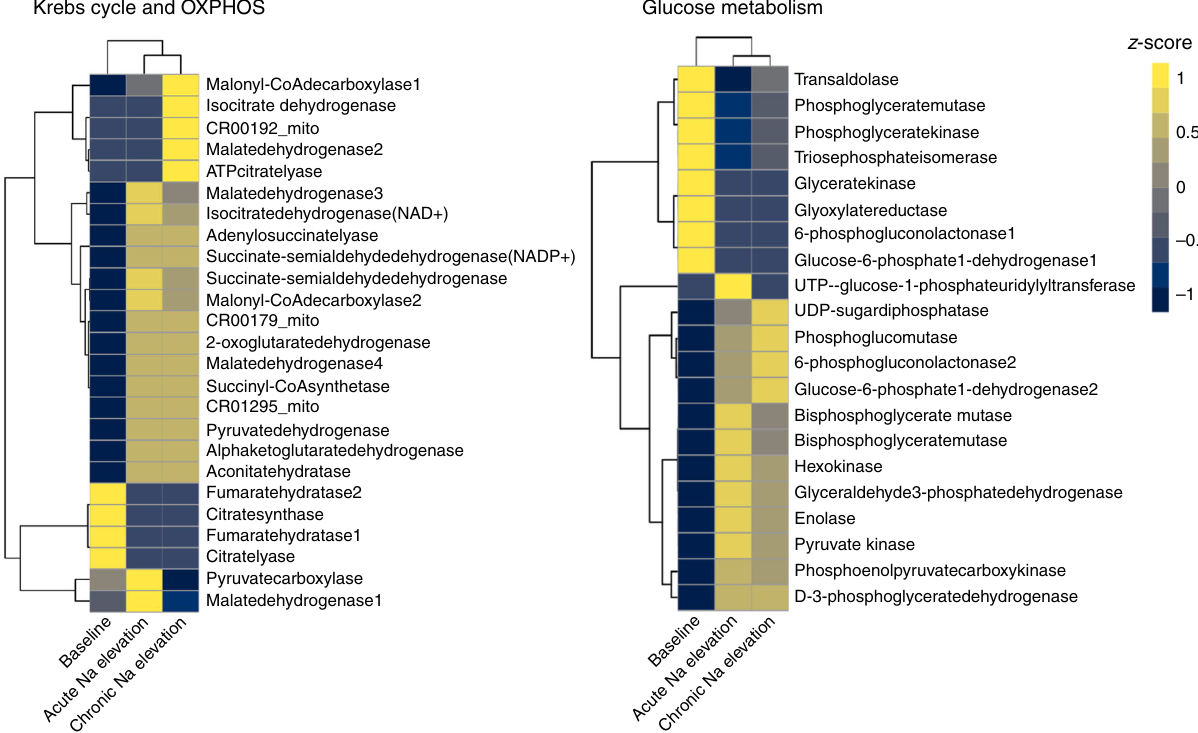
Fig. 5 Metabolic adaptation in response to acute and chronic Na elevation. Unsupervised hierarchical clustering of estimated z-scored fl ux rate changes reveals metabolic adaptation in response to [Na] i elevation. Heat maps summarize results for reactions in the Krebs cycle, OXPHOS, and glucose metabolism. Flux distributions were calculated by Flux balance analysis (FBA) using the mammalian network of cardiac metabolism, CardioNet. Z-scores were calculated to visualize how many standard deviations an estimated fl ux rate is away from the mean across all experimental groups. The z-score describes the distance from the mean for a given fl ux rate as a function of the standard deviation. For example, a z-score equal to 1 represents a fl ux for a given experimental group that is 1 standard deviation greater than the mean across all experimental groups. The colour scale indicates the degree to which estimated fl ux rate changes are predicted to be respectively lower or higher in response to Na i elevation. Source data are provided in Supplementary Data 1.